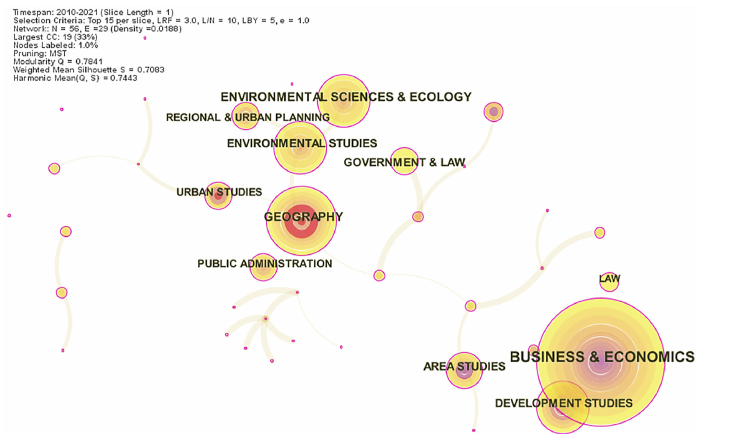
Figure 2. Discipline distribution network map of research on SEZs